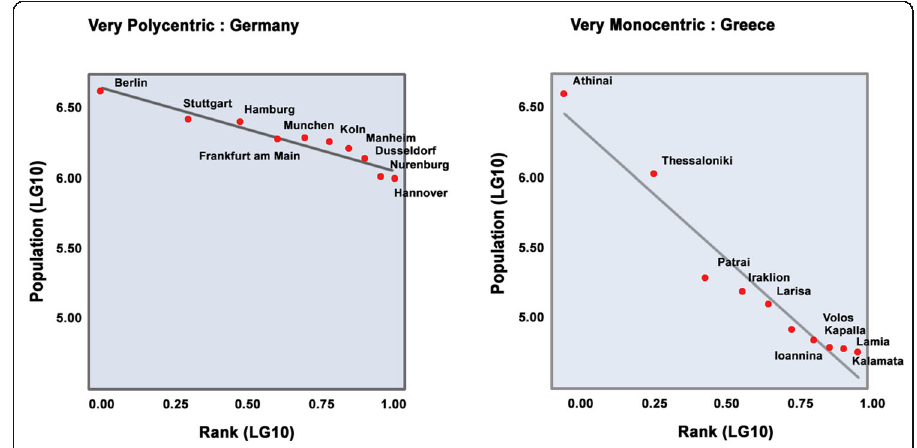
Fig. 1 Polycentric and monocentric countries in ESPON